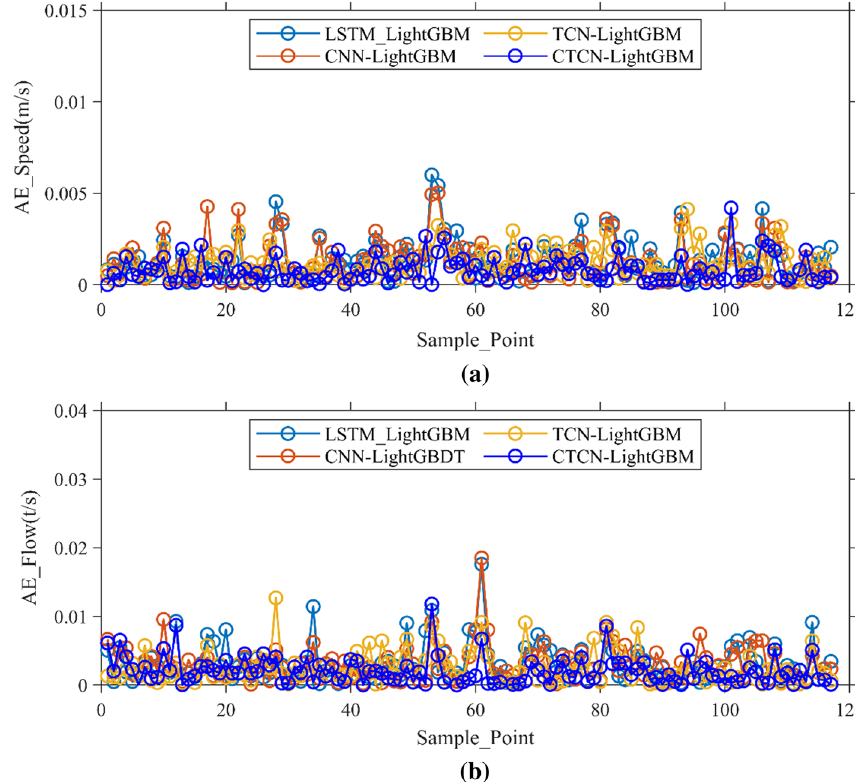
Fig. 10 a Absolute error values of actual prediction results for truck speed adjustment. b Absolute error values of actual prediction results for chute flow